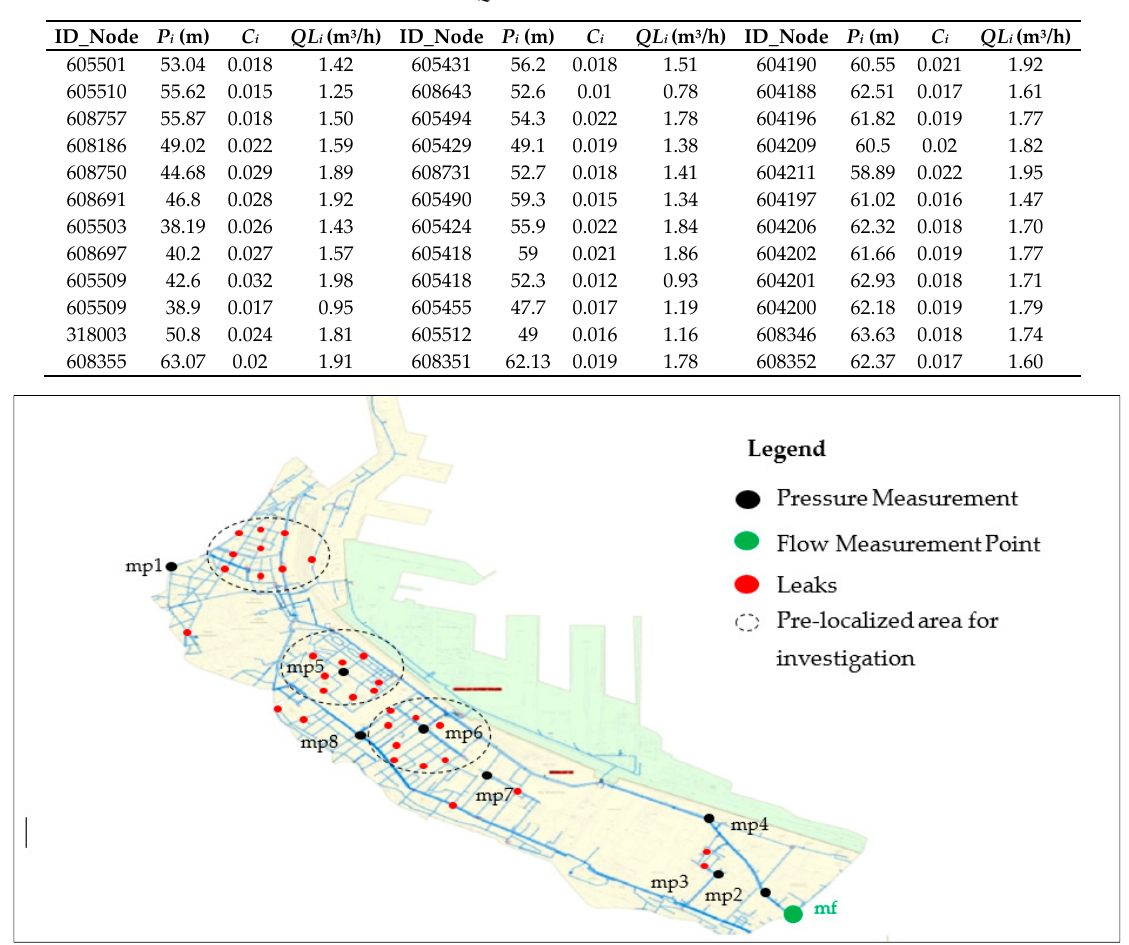
Table 2. Quantification of the leaks.